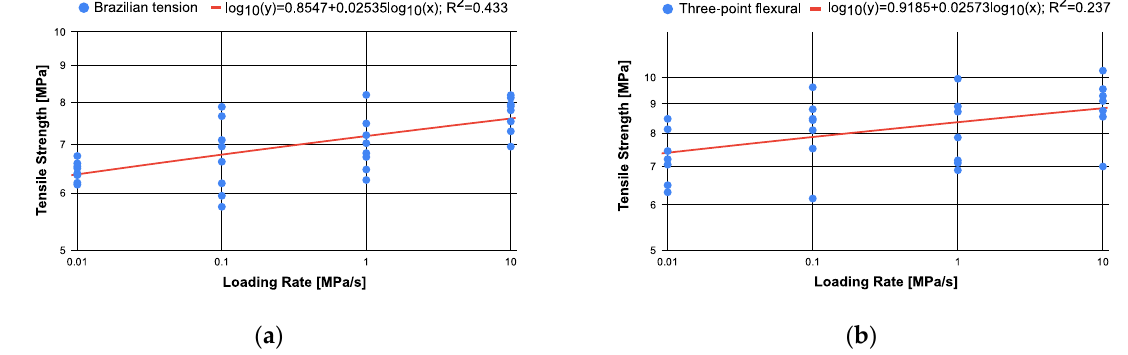
Figure 10. Tensile strength versus loading rate: ( a ) Brazilian tension test; ( b ) three-point flexural test.